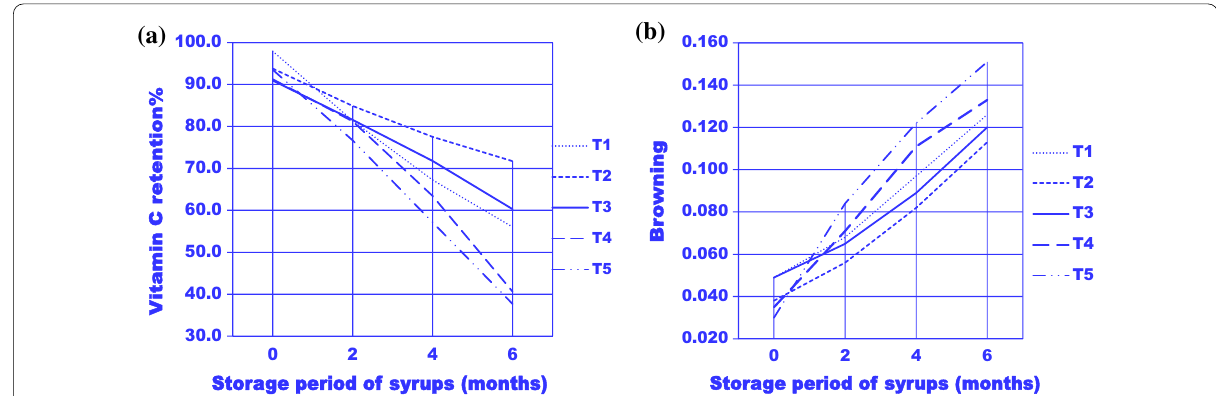
Fig. 2 Change in vitamin C and browning in different syrups during the storage